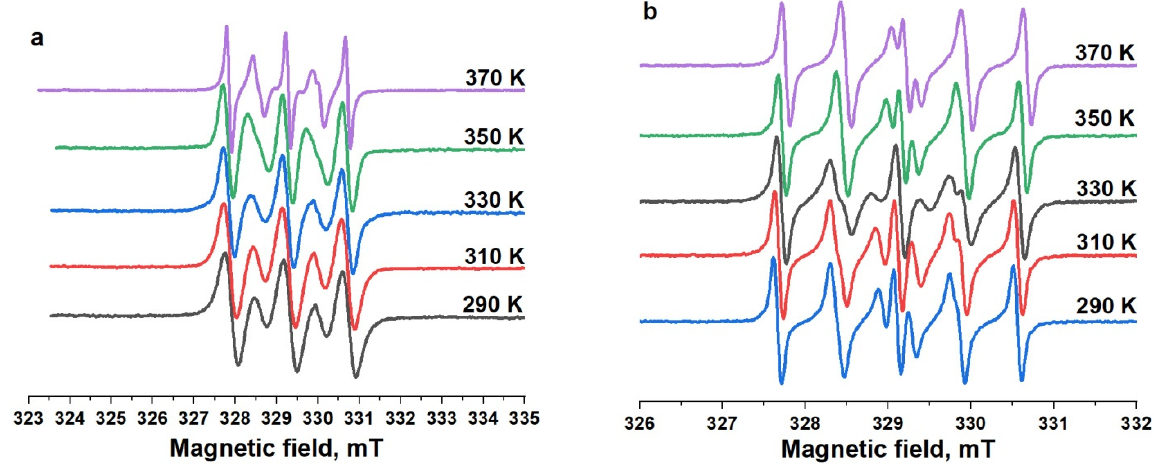
Figure 3. CW EPR spectra of diluted degassed toluene solutions of biradicals 3 ( a ) and 4 ( b ), as recorded at different temperatures T = 300 K.